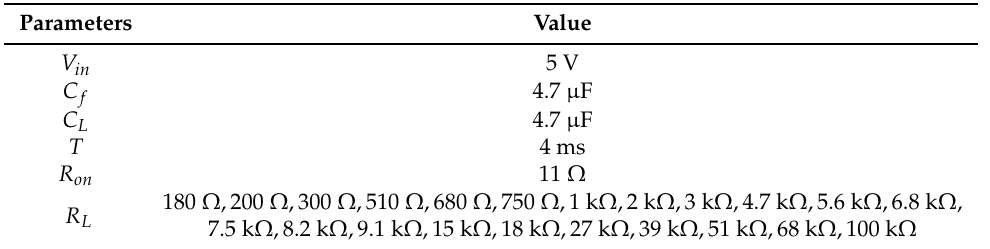
Table 2. Circuit parameters for